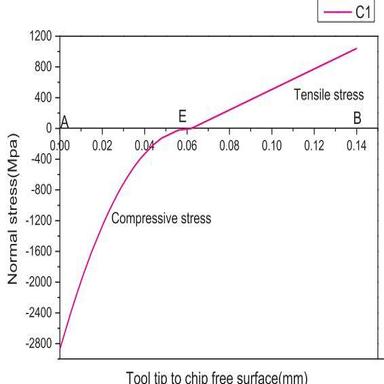
The stress curve on the main deformation zone.